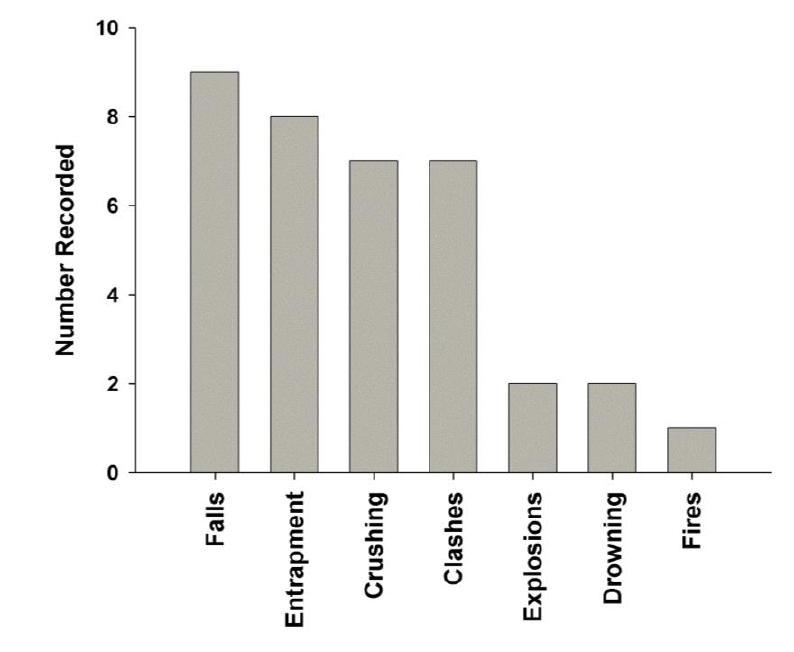
Figure 3. Causes of accidents reported from a review of media